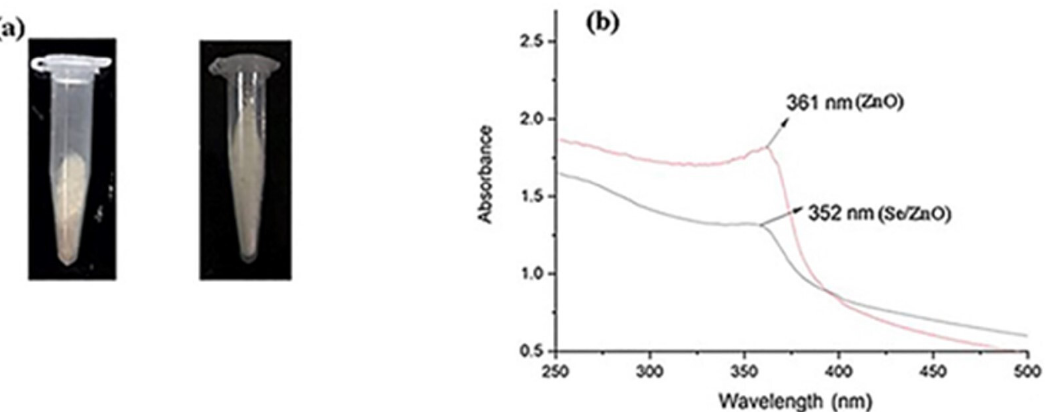
Figure 1. Initial confirmation of ZnO NPs and Se/ZnO NPs synthesis: ( a ) Fine white powdered nanoparticles obtained for ZnO NPs and Se/ZnO NPs and ( b ) UV-Vis spectroscopy of ZnO NPs and Se/ZnO NPs.